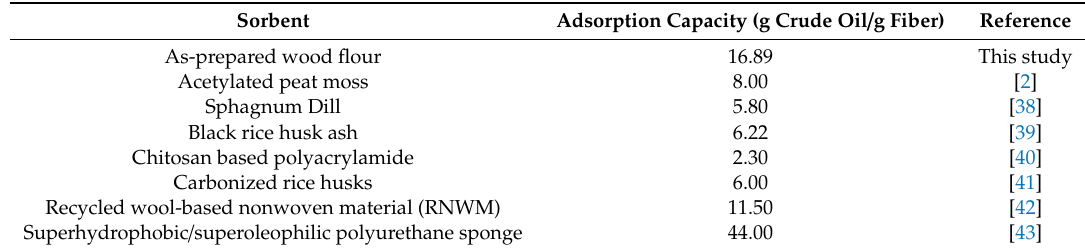
Table 1. A comparison of the oil adsorption capacities of various